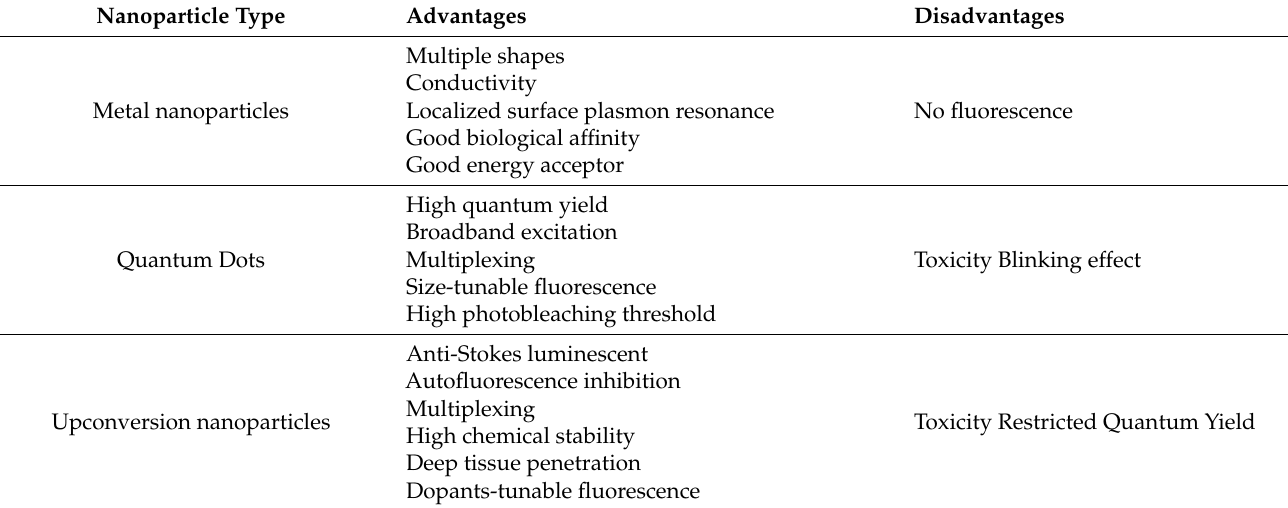
Table 4. Advantages and disadvantages of metal nanoparticles, quantum dots and upconversion nanoparticles. Nanoparticle